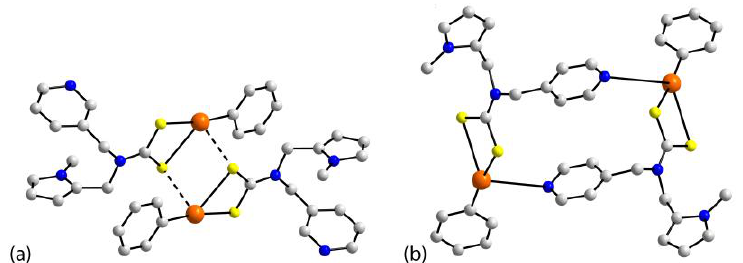
Figure 13. ( a ) The supramolecular dimer in [PhHg(L 17 )] 2 ( 43 ) mediated by the Hg · · · S interactions and ( b ) the di-nuclear molecule in [PhHg(L 18 )] 2 ( 45 ).